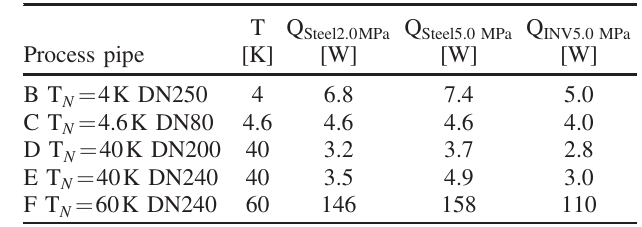
TABLE IV. Calculating the forces acting on strong fixed supports for Invar ® process pipes. Process